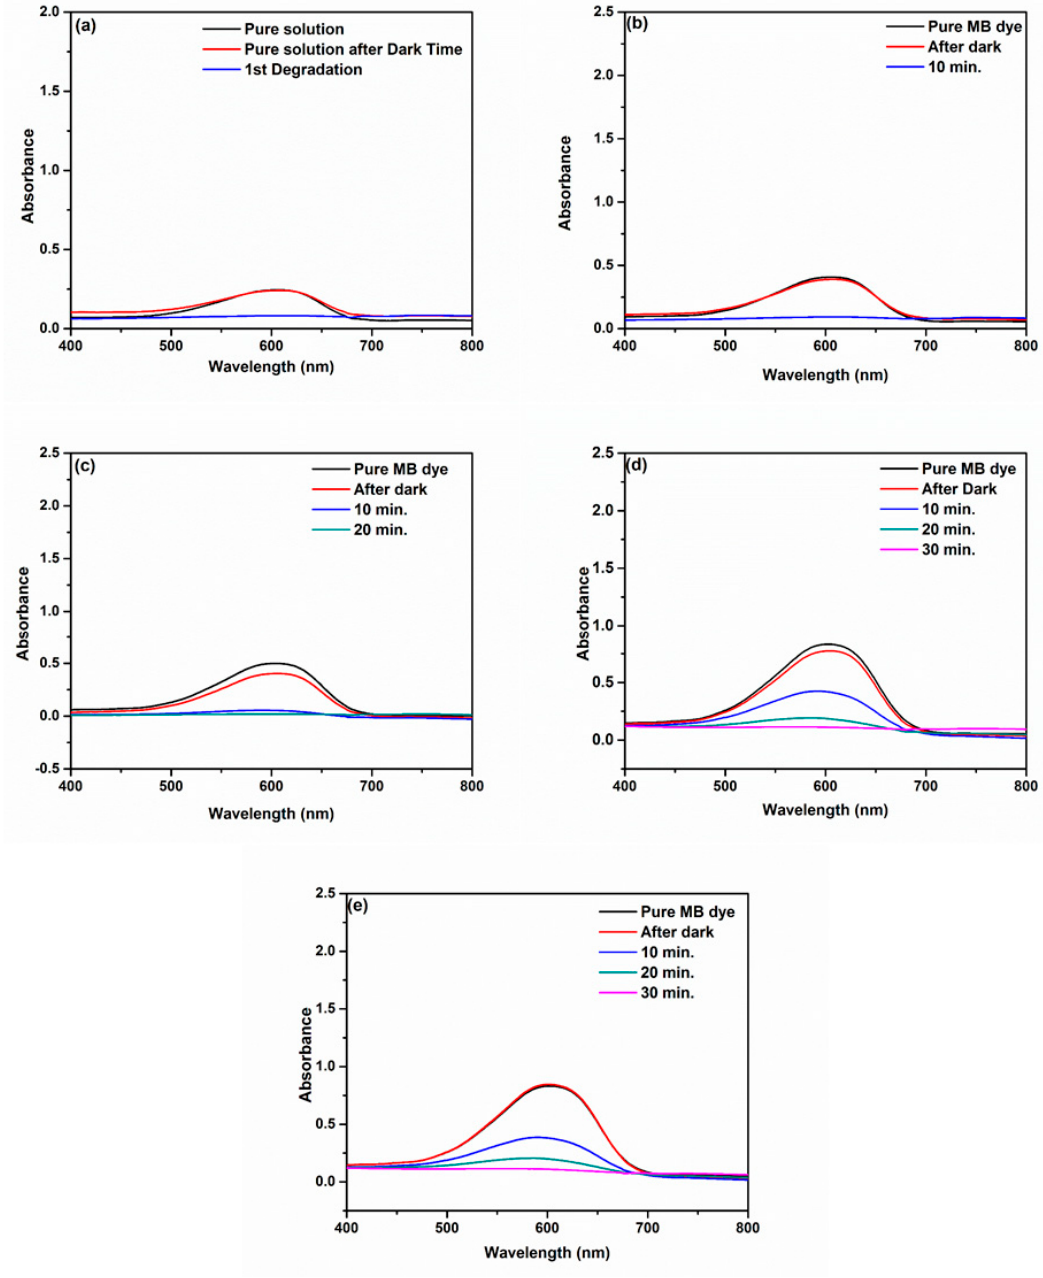
Figure 8. MB dye decolorization by 2.5% AgFeO 2 / rGO / TiO 2 photocatalyst for various concentrations: